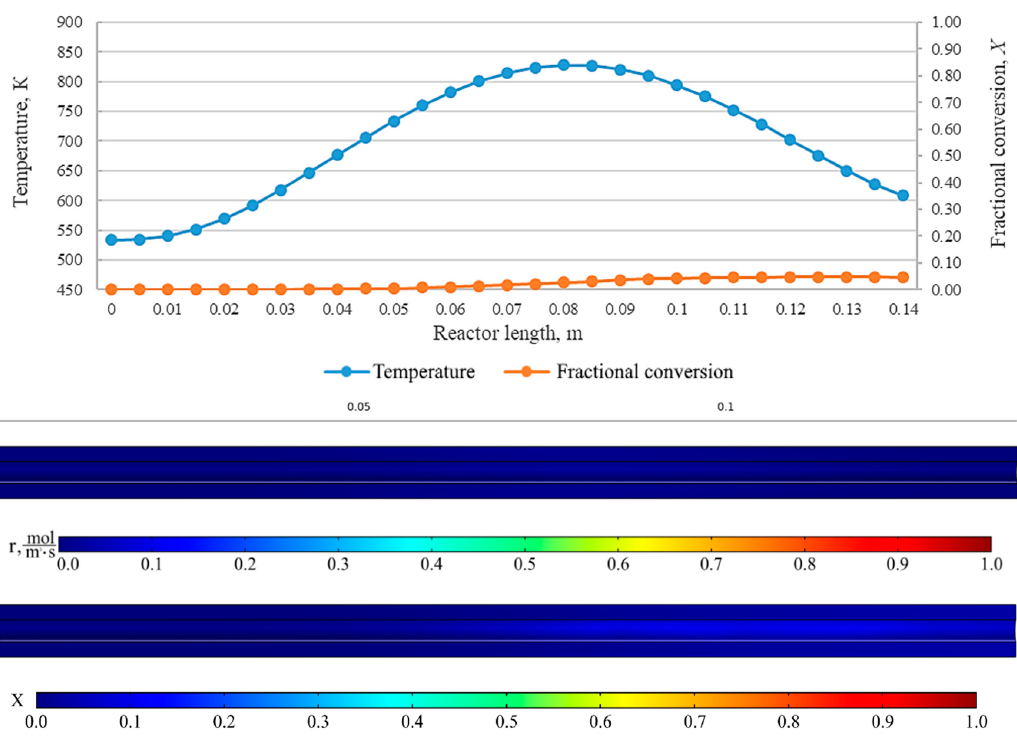
Figure 21. From top to bottom: temperature and fractional conversion curves, profiles of the reaction rate and fractional conversion along the reactor length for the experiment cyGOm_550_129 (Tmax = 550 °С , 𝑉(cid:4662) = 3.0 L/min).